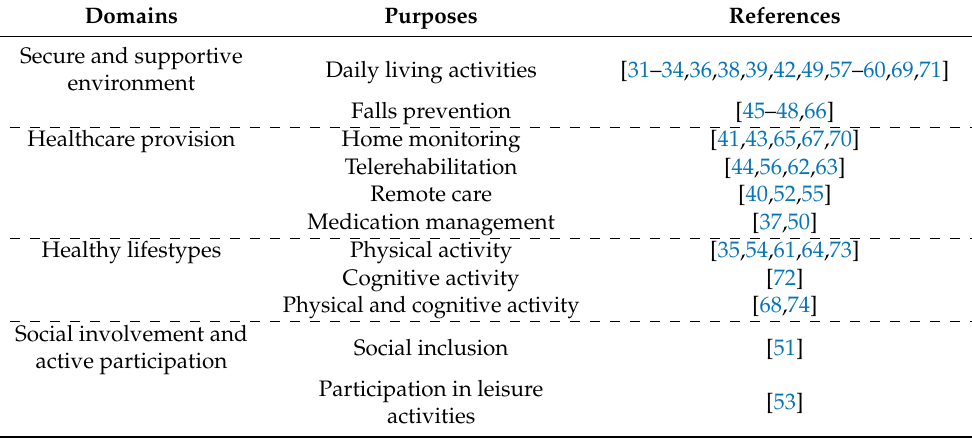
Table 2. Domains and purposes of the AAL solutions reported by the included studies.